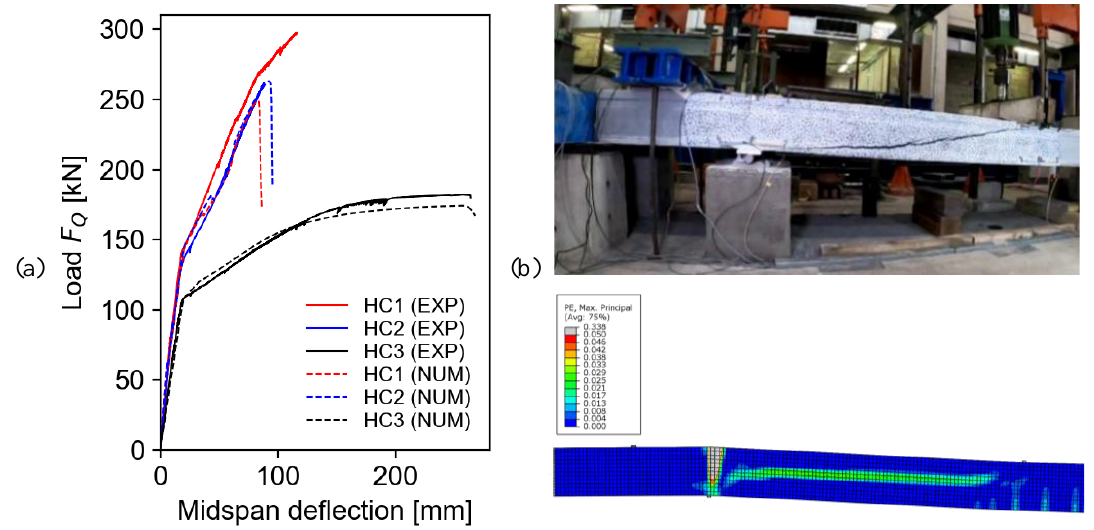
Figure 4: Comparison of experimental results and numerical model: (a) load-displacement graphs; (b) crack pattern at failure in restrained test HC1 [6].